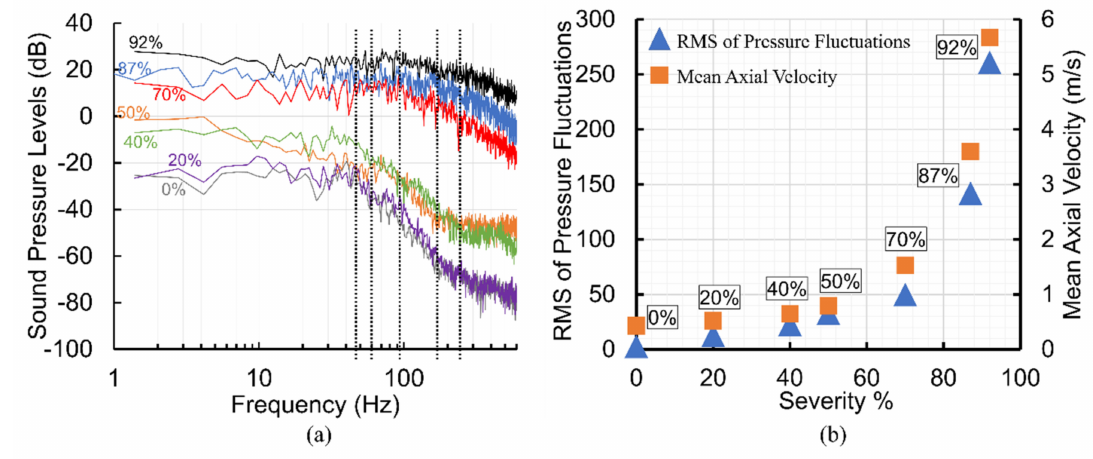
Figure 8. For all severity cases: ( a ) Sound pressure level (SPL) variation at different frequencies of acoustic pressure and ( b ) exponential increase in RMS of pressure fluctuations and mean axial velocity with an increase in stenosis